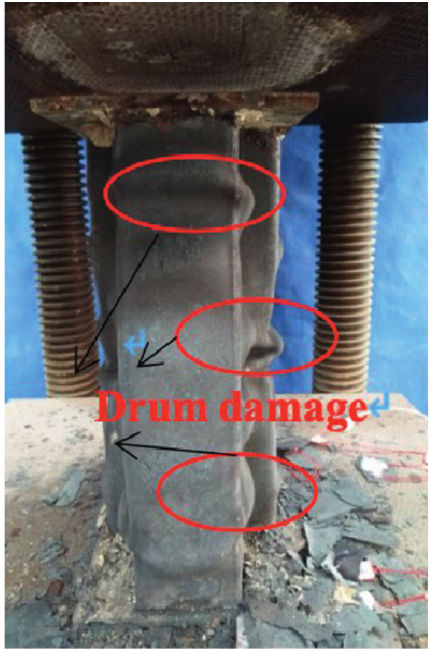
Figure 9: Data acquisition system.